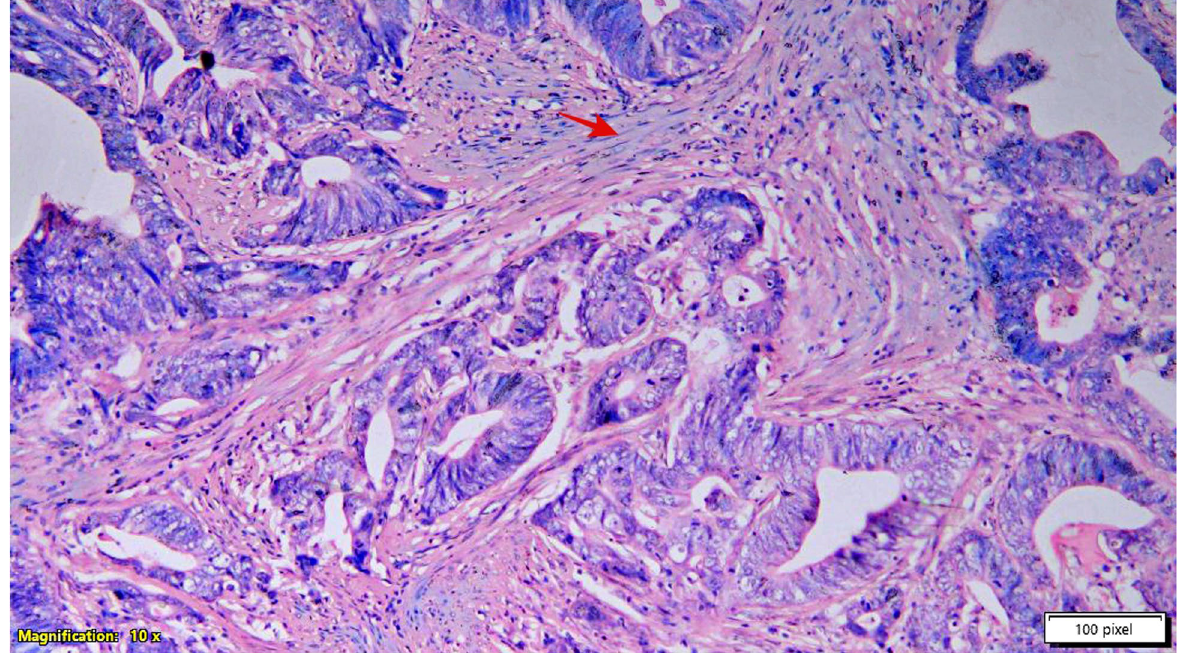
Fig. 1 Mature desmoplastic reaction. Invasion of tumor with surrounding collagen fibers with spindle-shaped fibrocytes stratified in multiple layers (red arrow) (H&E, 10 ) ×